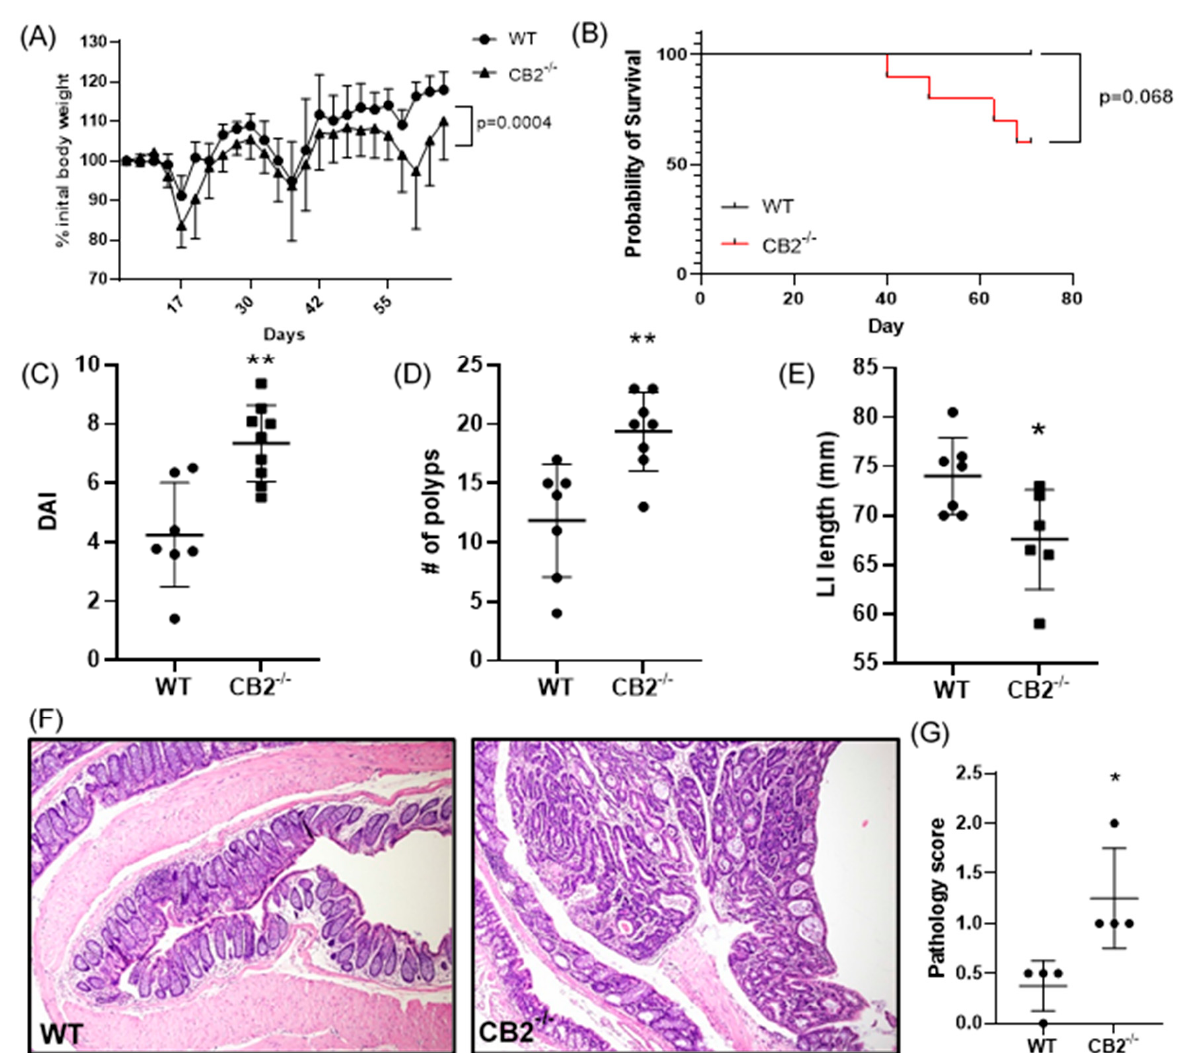
Figure 3. The CB2 receptor protects against CRC development in the AOM/DSS model. ( A ) Body weight expressed as percent (%) of initial weight on day 0; only mice that survived the entirety of the experiment were included, two-way ANOVA. ( B ) Survival curve, Mantel Cox test; ( C ) disease activity index (DAI) as measured by colonoscopy at week 7; this includes mice that did not survive the entirety of the experiment (WT, n = 7; CB2 − / − , n = 9). ( D ) Number of polyps in the large intestine; this includes two CB2 − / − mice that died two days before the conclusion of the experiment (WT, n = 7; CB2 − / − , n = 8). ( E ) Length of the large intestine (LI). ( F ) Representative histological images of WT (left) and CB2 − / − (right) colons. Original magnification × 40. ( G ) Pathological score graded according to the following scale: 0—normal tissue; 1—chronic inflammation, ulceration, atrophy, or hyperplasia; 2—cellular atypia, metaplasia or mitotic figures; 3—dysplasia; 4—positive carcinoma. Mann–Whitney U test or Student’s t-test unless otherwise stated. WT, n ≥ 4; CB2 − / − , n ≥ 4 as indicated. * p < 0.05, ** p <